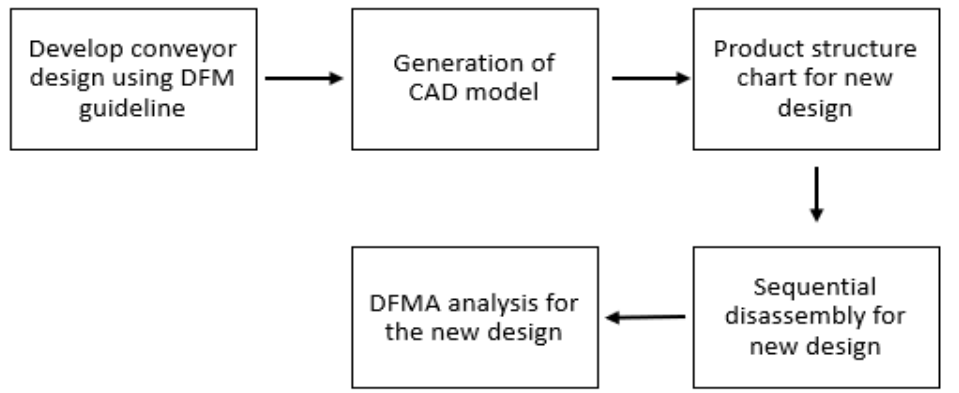
Figure 12. Framework for processing new design for DFMA analysis.